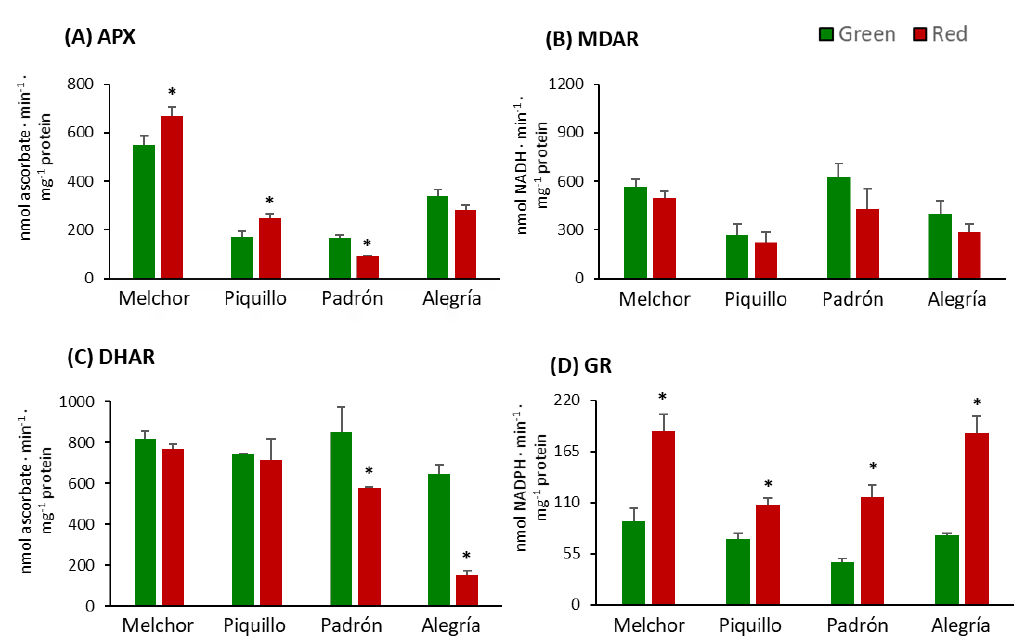
Figure 6. Activity of enzymes from the ascorbate—glutathione cycle in pericarp from fruits of four pepper varieties at two ripening stages. ( A ) Ascorbate peroxidase (APX). ( B ) Monodehydroascorbate reductase (MDAR). ( C ) Dehydroascorbate reductase (DHAR). ( D ) Glutathione reductase (GR). Data are the means ± SEM of three replicates determined from five fruits of the four varieties and at the two ripening stages. Asterisks indicate significant differences of red fruits with respect to green fruits for each variety ( t -student, p < 0.05).